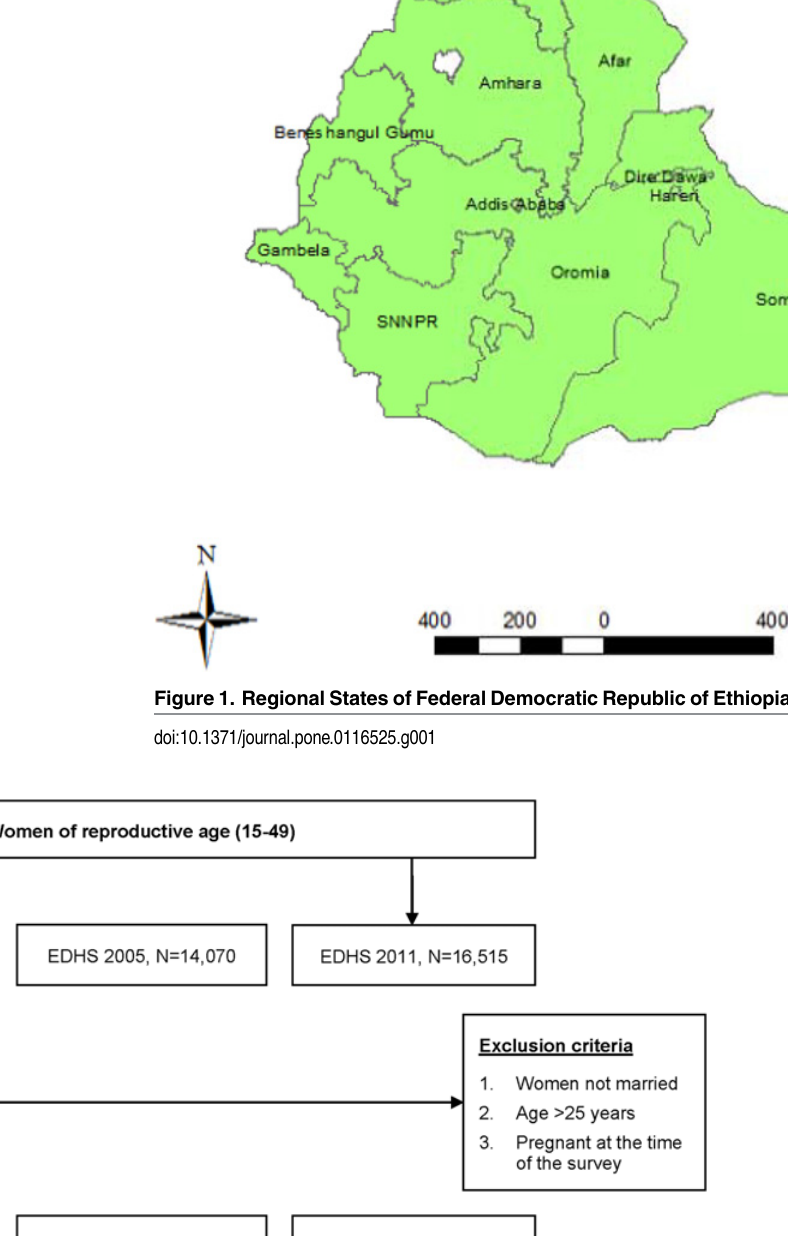
PLOS ONE | DOI:10.1371/journal.pone.0116525 January 30,